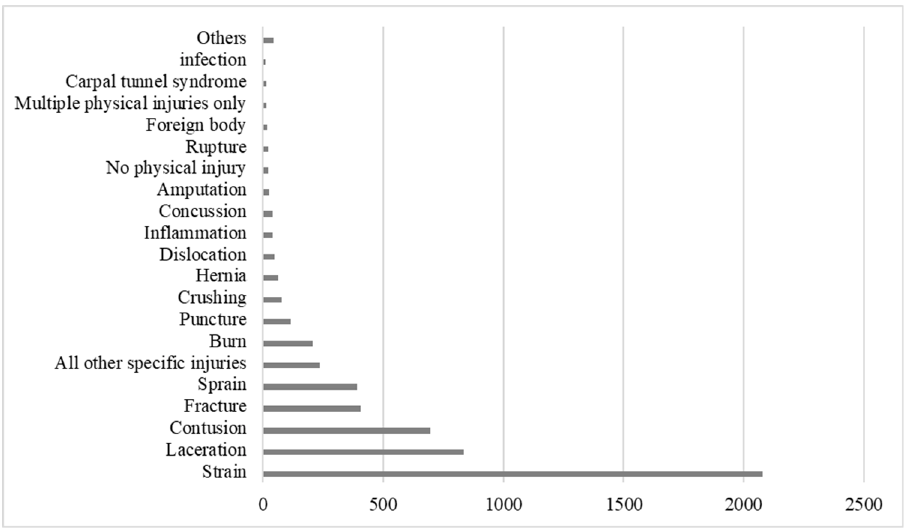
Figure 4. Frequency of injury nature in grain elevators.